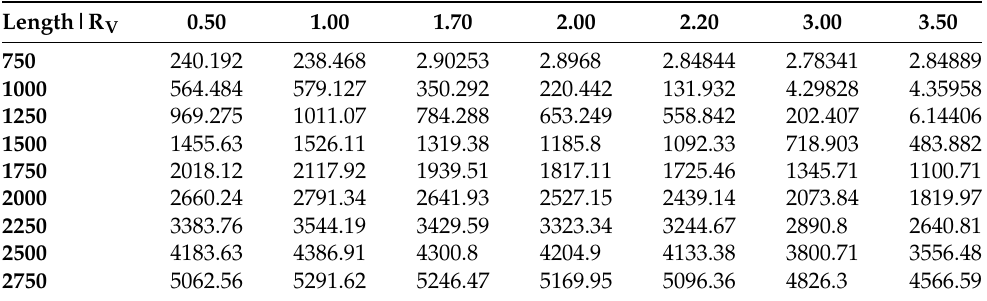
Table A4. Execution times in milliseconds for the CPU-based implementation of the decreasing ring simulation. On the left the number of cells (length) while on top the value considered for R V